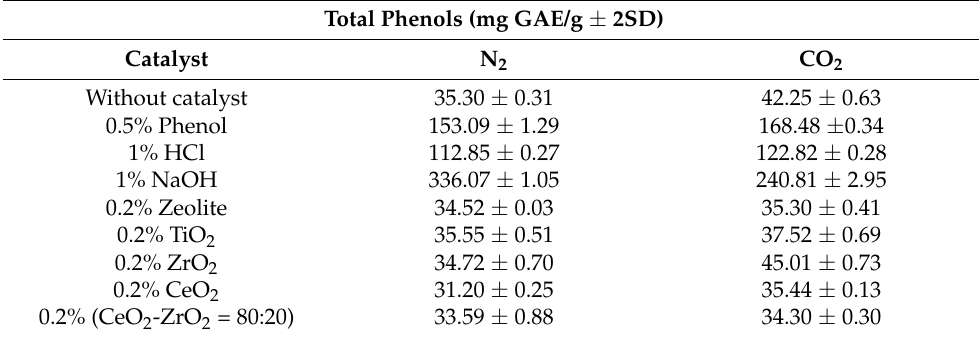
Table 1. The content of total phenols in aqueous fractions obtained by hydrothermal treatment of lignin in the presence of different catalysts.